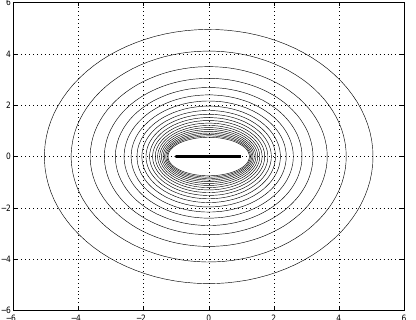
1 , 1] is displayed −